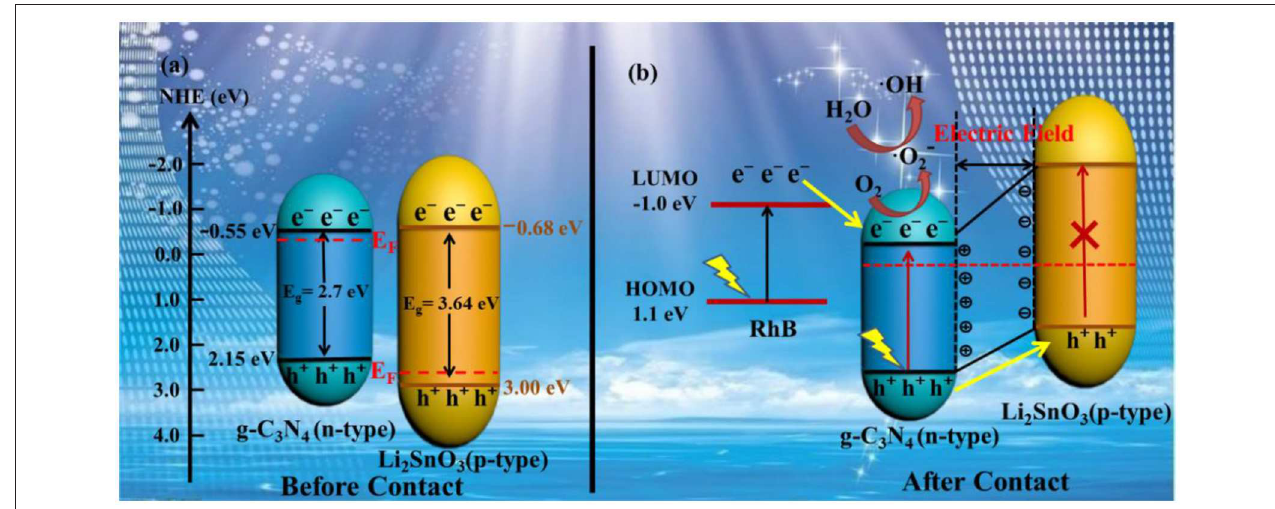
FIGURE 10 | Schematic of charge transfer between p -type Li 2 SnO 3 and n -type g-C 3 N 4 (a) before contact and (b) after contact forming the p-n